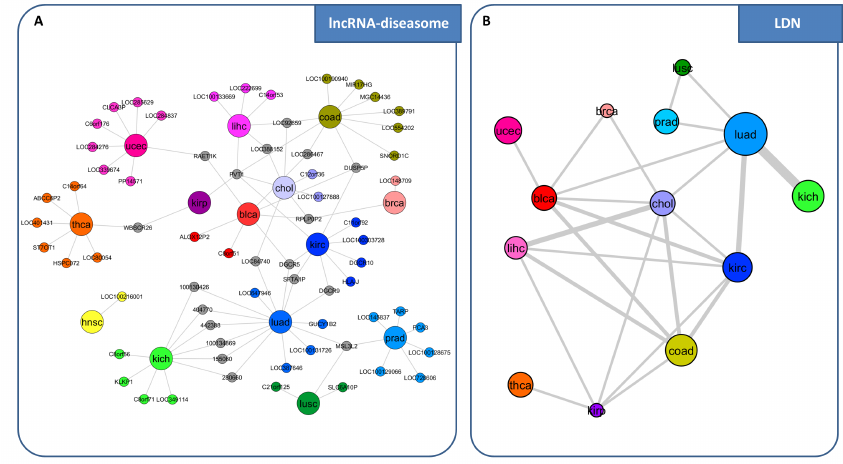
Figure 8. Comparative analysis of lncRNAs acting as switch genes in the large panel of TCGA cancer datasets. ( A ) lncRNA-diseasome. The bipartite network is composed of two disjoint sets of nodes with different size: the larger ones correspond to the analyzed human cancer types from TCGA, whereas the smaller ones correspond to all lncRNAs acting as switch genes. A link occurs between a tumor type and a lncRNA if the lncRNA acts as switch gene for that tumor. Different colors are associated to different tumor types. lncRNAs are colored based on the tumor type to which they belong. Nodes are light gray if the corresponding lncRNAs are associated with more than one tumor type. ( B ) lncRNA-disease network (LDN). The LDN is the projection of the lncRNA-diseasome bipartite network, in which nodes correspond to tumor types (diseases) and two diseases are connected if there is at least one lncRNA that acts as switch gene in both. The width of a link is proportional to the number of lncRNAs that are acting as switch genes in both diseases. The size of a node is proportional to the number of lncRNAs acting as switch genes for that disease. Different node colors are associated with different